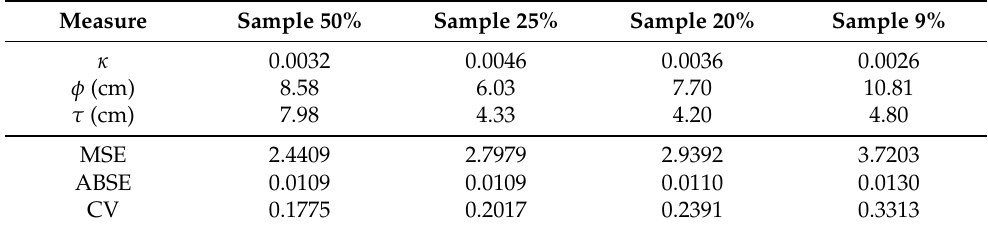
Table 3. Posterior distribution of the parameters and prediction errors for the systematic samples